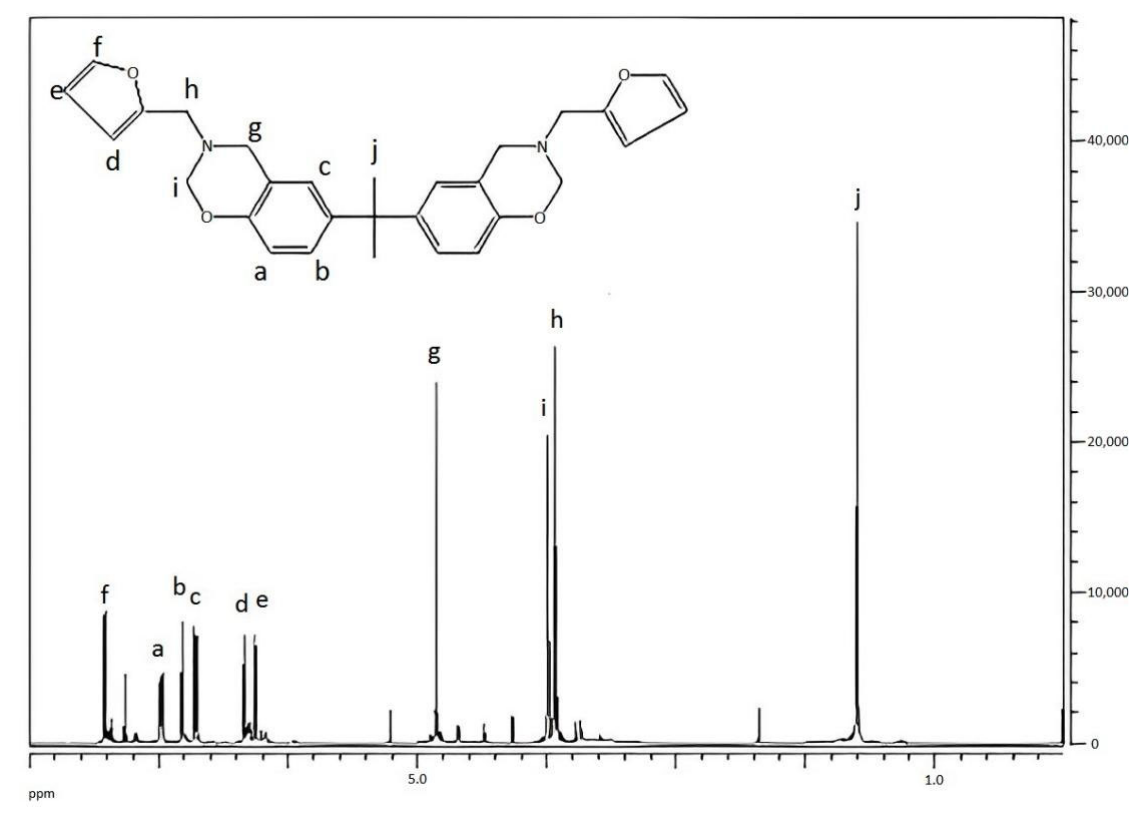
Figure 14. 1 H ‐ NMR spectrum of benzoxazine (bisphenol A). Figure 14. 1 H-NMR spectrum of benzoxazine (bisphenol